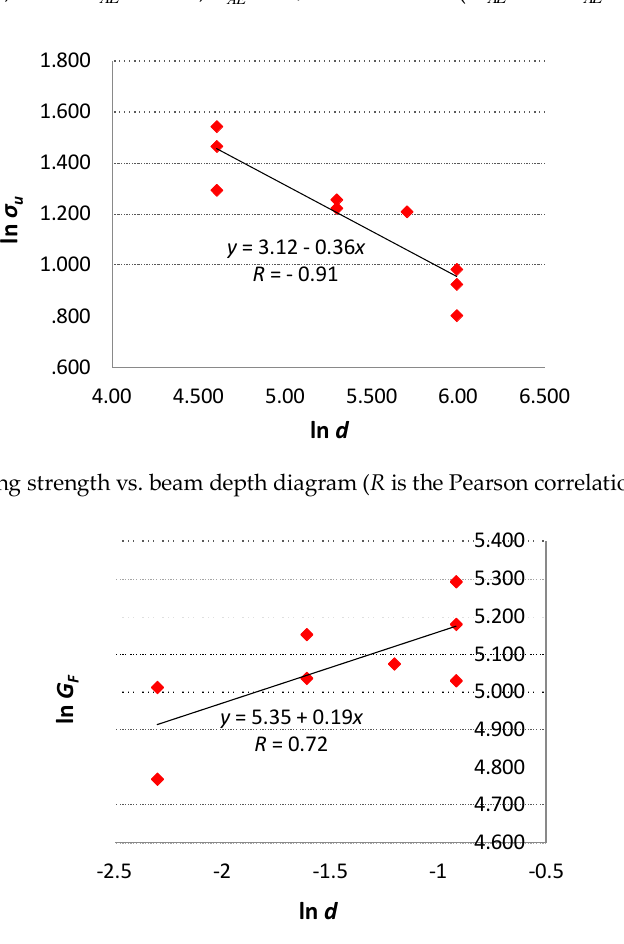
Figure 5. Fracture energy vs. beam depth diagram ( R is the Pearson correlation coefficient).